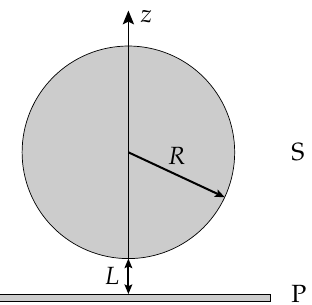
Figure 1. Sphere (S) of radius R and plate (P) separated by a distance L